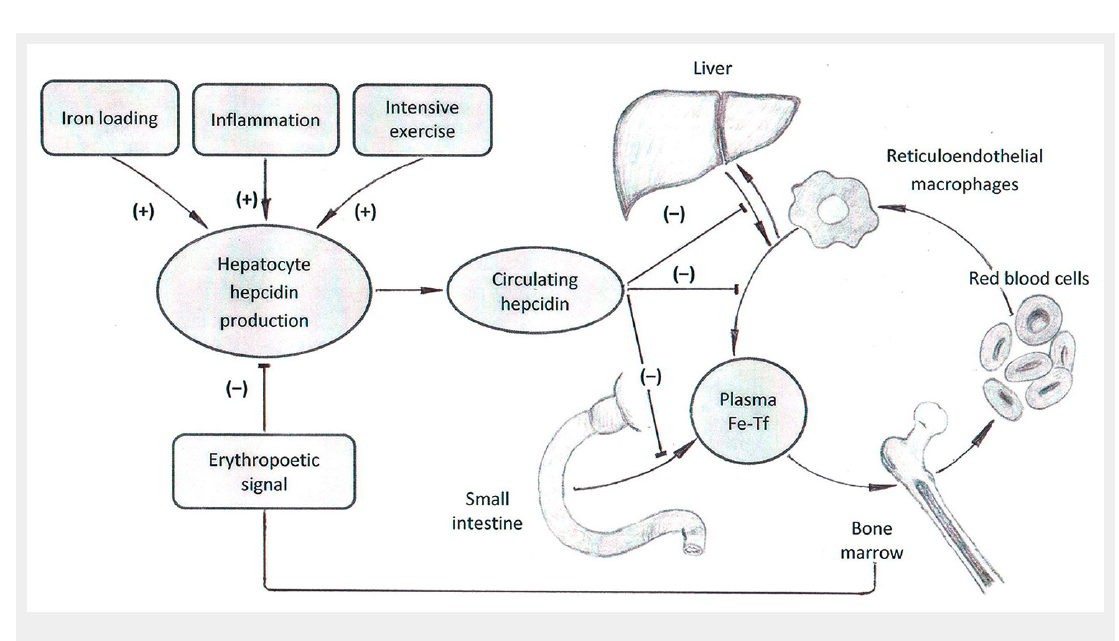
Figure 2 Hepcidin effects, adapted after Young and Zaritsky 2009